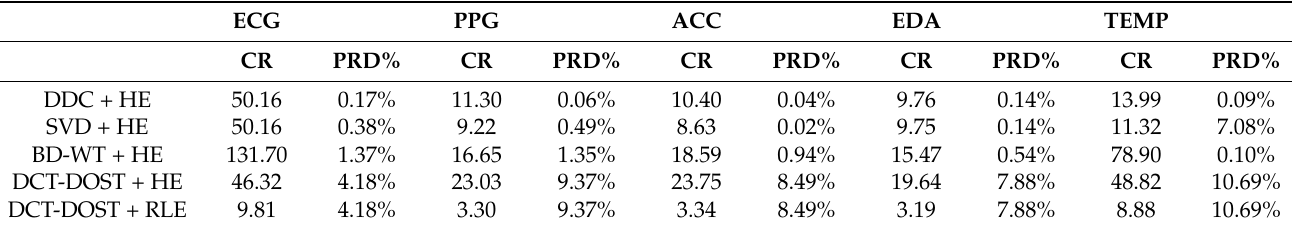
Table 1. Compression Ratio (CR) and Percent Root-mean-square Difference (PRD%) of each data compression pipeline currently in the data compression toolbox for each of the wearable sensor biosignals: Electrocardiogram (ECG), photo- plethysmography (PPG), accelerometry (ACC), electrodermal activity (EDA), and skin temperature